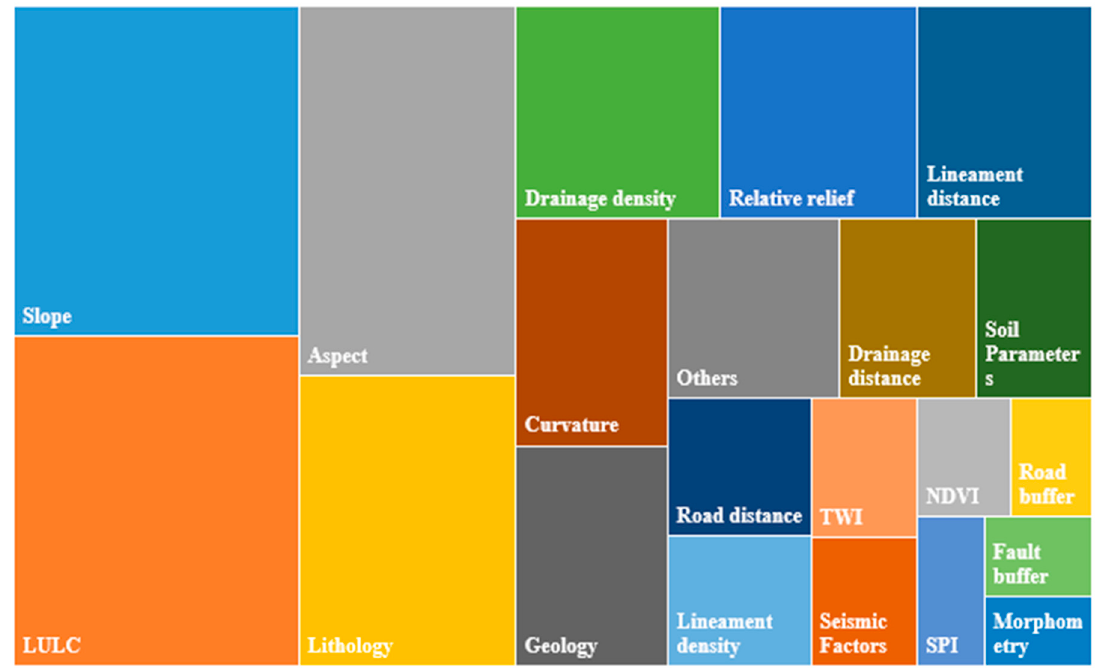
Figure 9. Tree map of the factors used for determining landslide hazard and susceptibility.